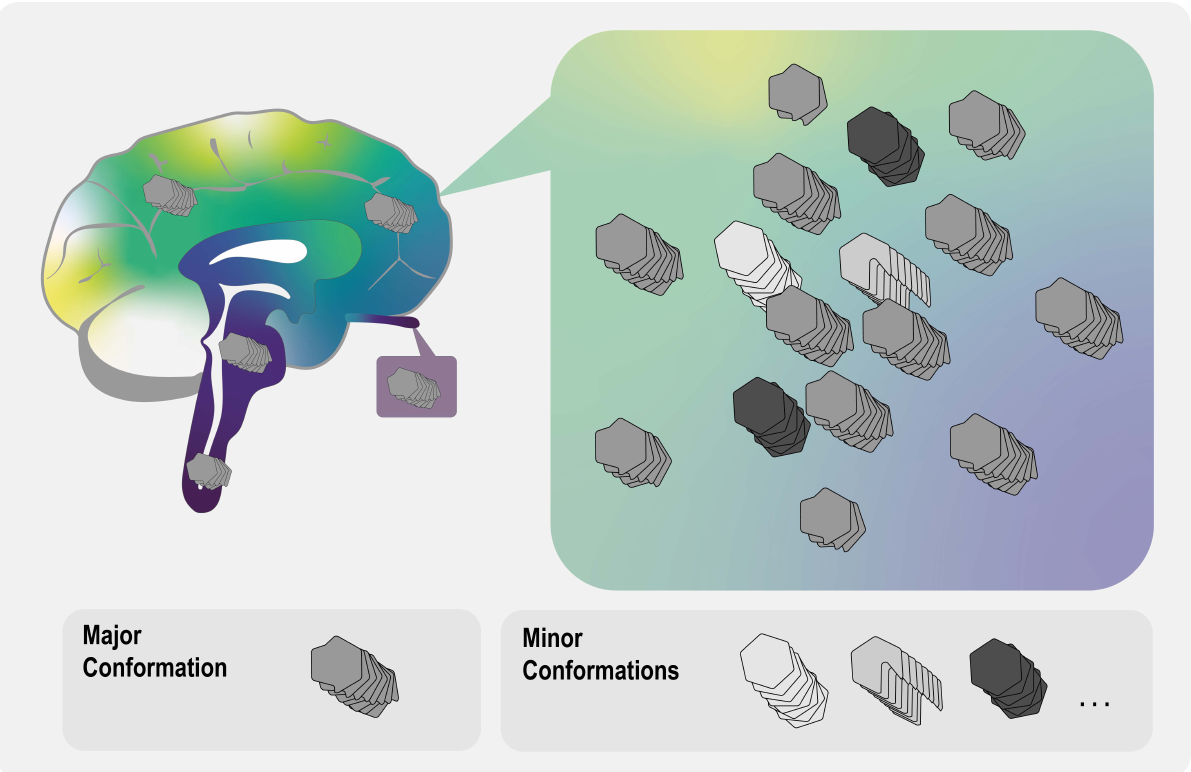
Figure 4. Graphical representation of the prion cloud model. Amyloid aggregates of the same protein may form a wide range of possible fibril or oligomer architectures. In prion and prion-like diseases, there likely exists one abundant major amyloid conformation, which would determine the strain characteristics, as well as a variety of less abundant minor conformations. In cases where a cellular degradation response is implemented against a certain major conformation, minor unaffected conformations may become more prevalent—a process referred to as strain